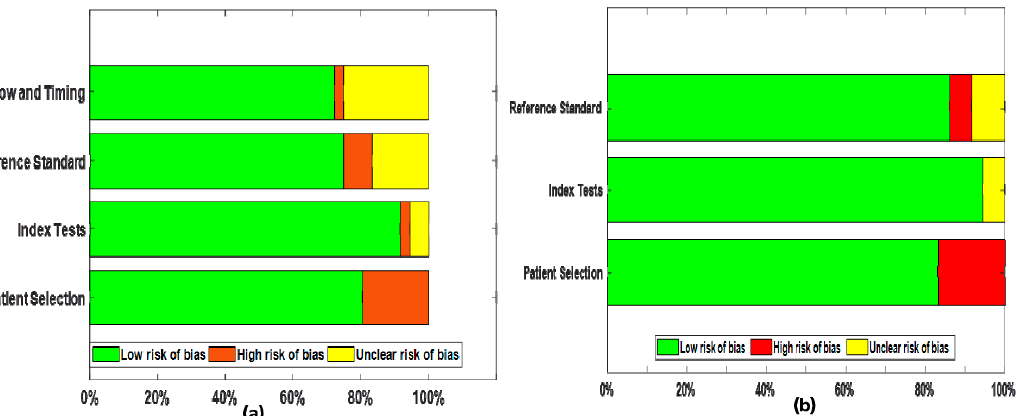
Figure 8. Stacked bar chart of QUADAS-2 domain versus the proportion of included studies for 36 studies ( a ) Risk of bias ( b ) Concerns regarding applicability. QUADAS-2 = Quality Assessment of Diagnostic Accuracy Studies 2.